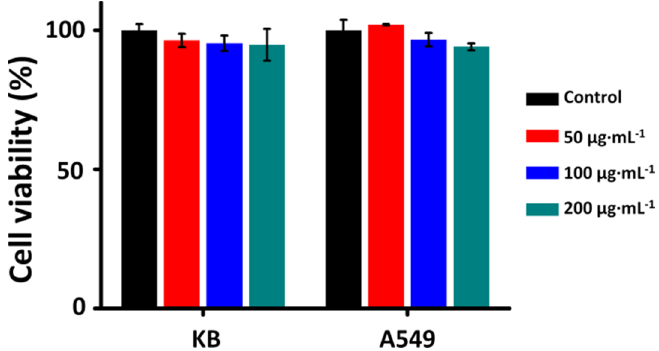
Figure 4. The dark cytotoxicity of N-TiO 2 -FA with the incubation concentrations of 50–200 μ g·mL − 1 on KB and A549 cells. The control groups of untreated cells were also shown for comparison. Data are expressed as mean ± SD ( n = 4).